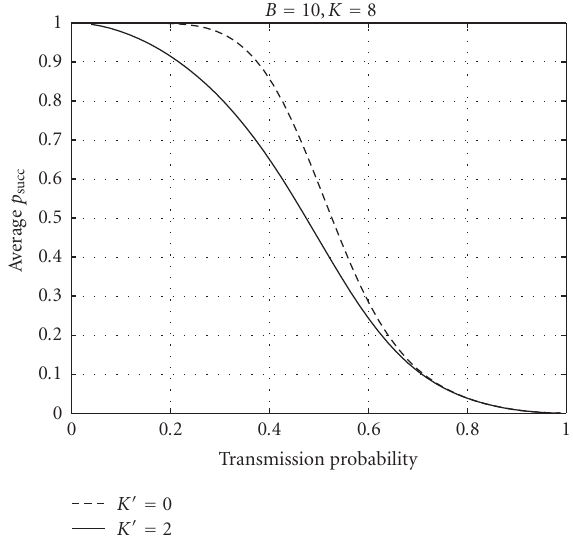
Figure 4: Average Probability of success for the linear case with static and dynamic K .